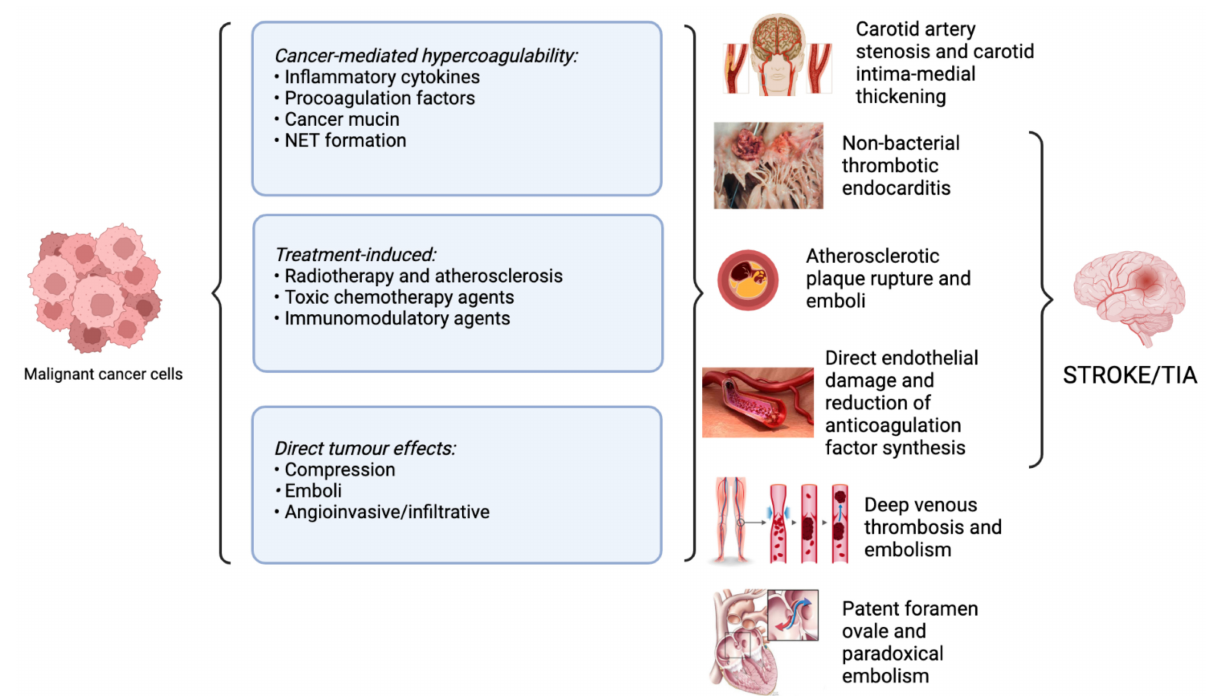
Figure 1. Overview of pathophysiological mechanisms of stroke in cancer patients. Abbreviations: NET: neutrophil extracellular trap; TIA: transient ischemic